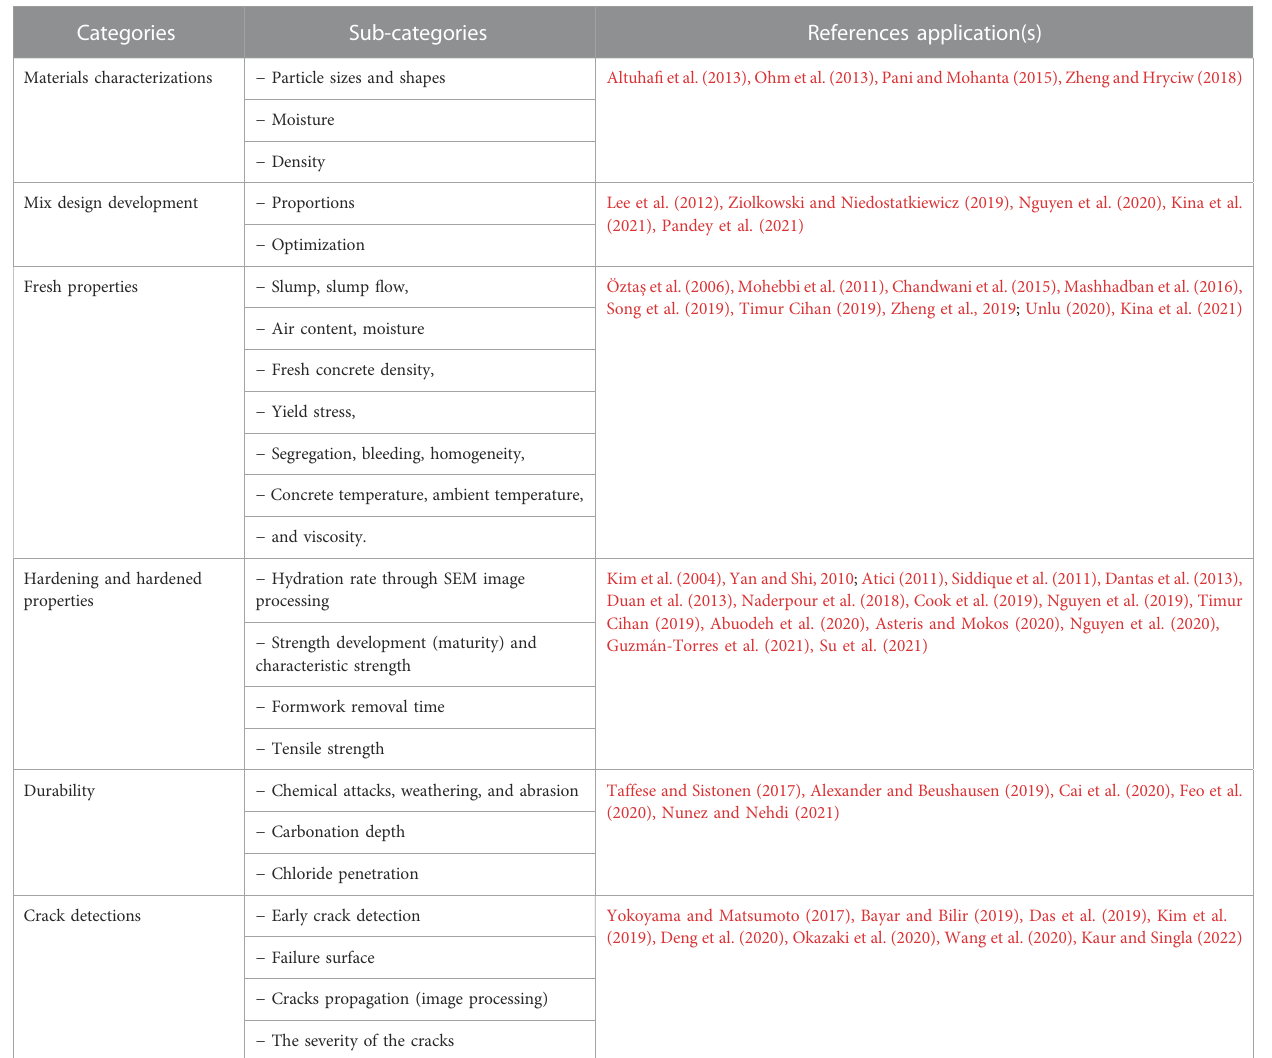
TABLE 1 Areas of ML application in concrete